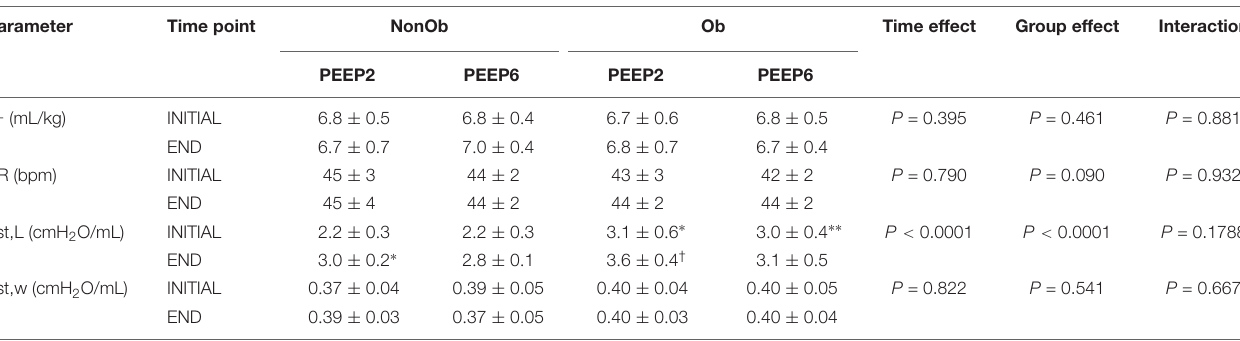
TABLE 2 | Respiratory